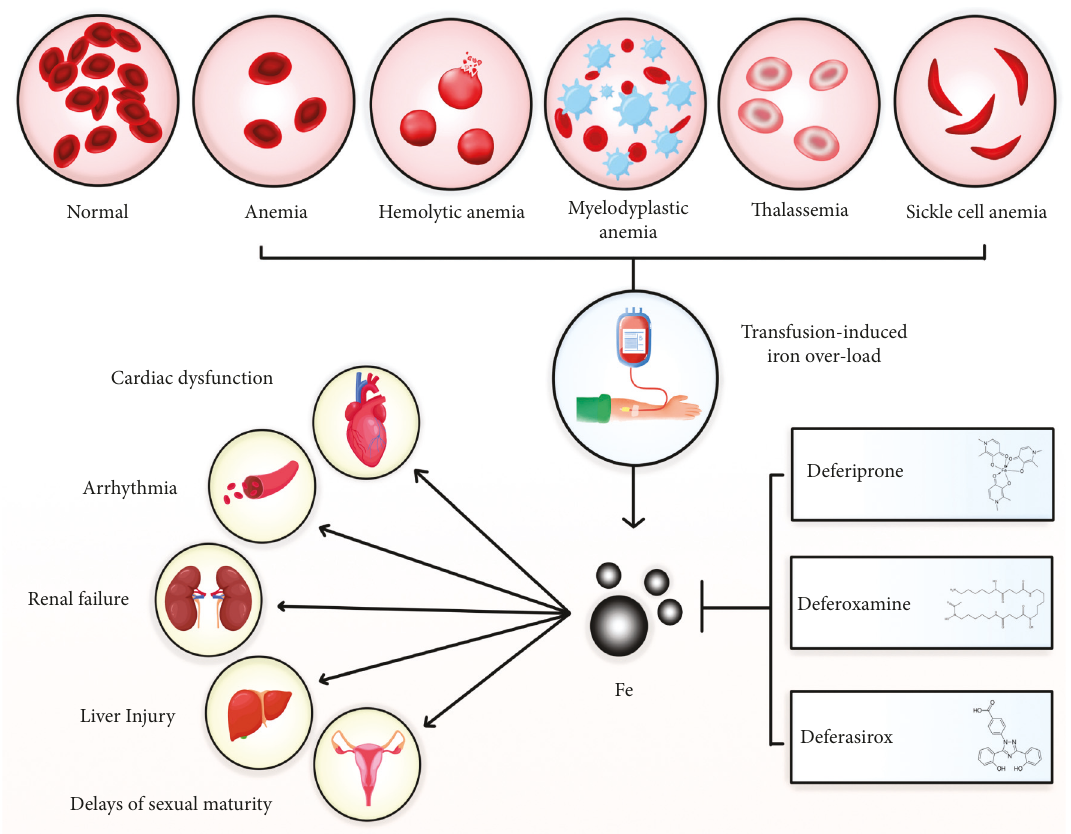
Figure 2: Deferoxamine, deferiprone, and deferasirox effects on transfusion-induced iron overload. Patients with aplastic anemia, he- molytic anemia, myelodysplastic anemia, thalassemia, and sickle cell anemia become transfusion dependent. Iron toxicity leads to free radical production, which causes severe side effects, including cardiac dysfunction, arrhythmia, renal failure, kidney damage, and delays in sexual maturity. Iron chelators can enter cells, bind free iron, and remove it from the body, thus inhibiting iron